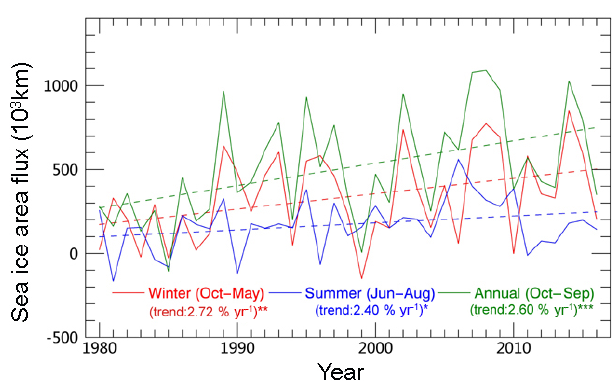
Figure 6. Annual and seasonal sea ice area fluxes between the PA and AA sectors over the period 1979–2016. The annual ice flow (an- nual cycle) is shown by the green line. Summer (from June through September) and winter (from October through May) fluxes are de- noted with blue and red lines, respectively. The dashed lines repre- senting the linearly fitted trends are obtained through the application of the least-squares method. The labels ∗ , ∗∗ , and ∗∗∗ correspond to the significance at the levels of 90%, 95%, and 99%,